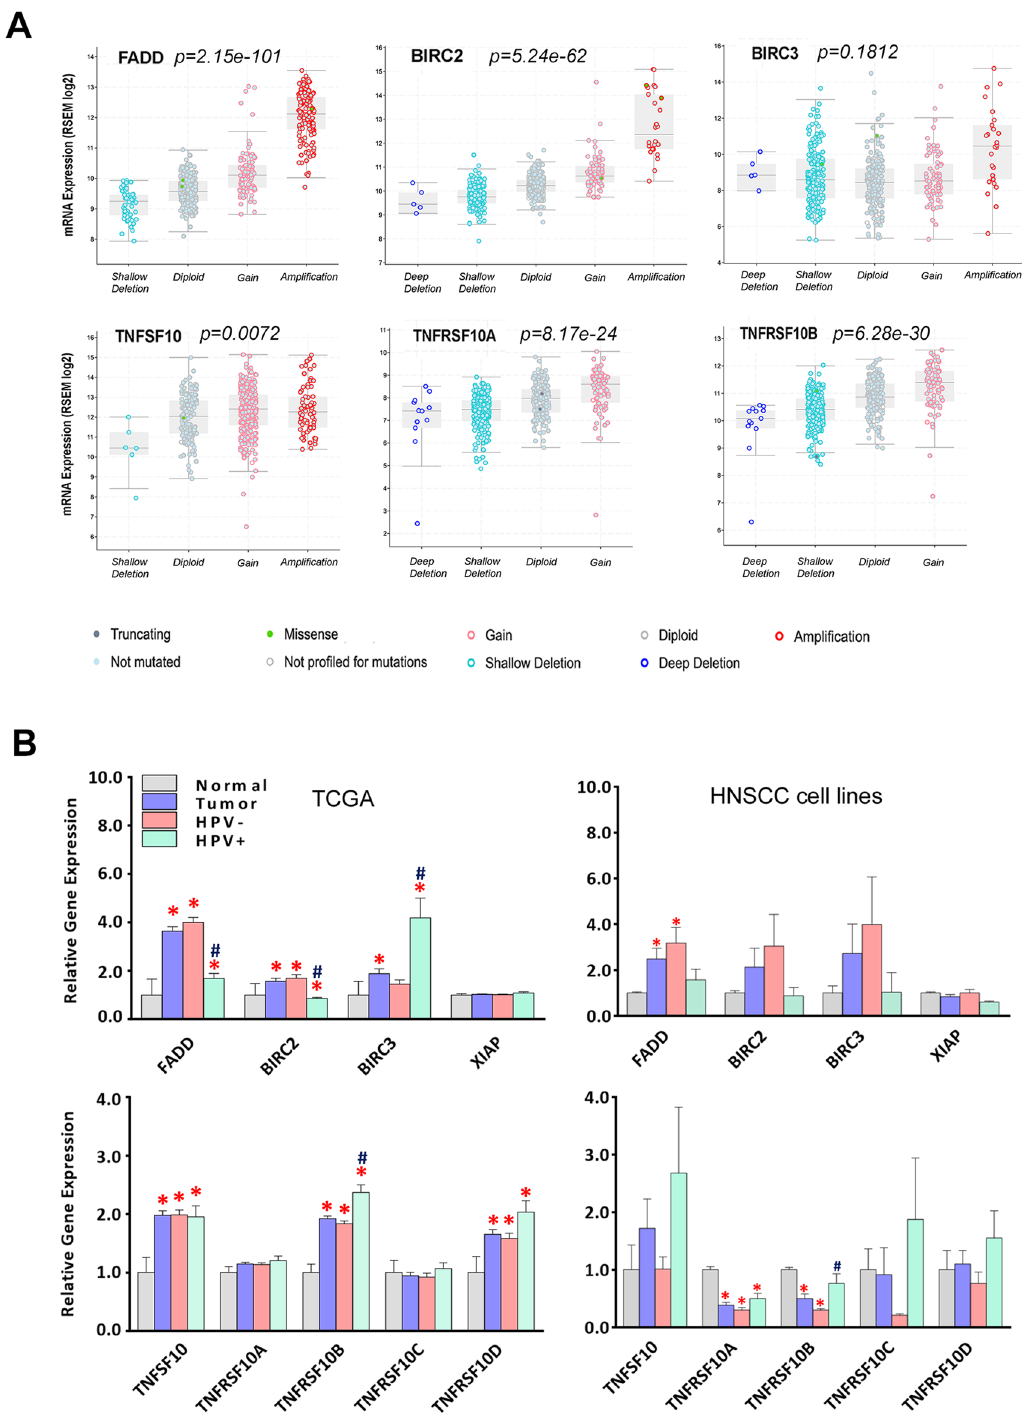
Figure 2. Association of copy number alterations with mRNA expression in HNSCC tumors and cell lines. ( A ) Expression and copy number status for six of nine genes are presented, including five with significant correlation between mRNA expression and DNA CN in 523 HNSCC tumor specimens from the TCGA data set. mRNA expression by RNAseq is presented in the y axis as the log2 scale. p-values present the significance of the Spearman correlation of mRNA expression as a function of CNV. ( B ) Expression of these genes in TCGA dataset (left) and HNSCC cell lines sequenced in our laboratory (right) are presented in a bar graph format, and the samples labeled as normal, tumor [HPV(−) plus HPV(+)], HPV(−), or HPV(+). The altered genes are presented by the relative gene expression levels as mean ± standard errors (SE). Statistical difference was calculated by Student’s t test, p < 0.05. * indicates statistical significances when compared with normal mean, and # indicates significance when compared samples different in HPV